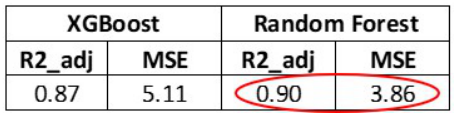
Figure 15. Comparison of results through different